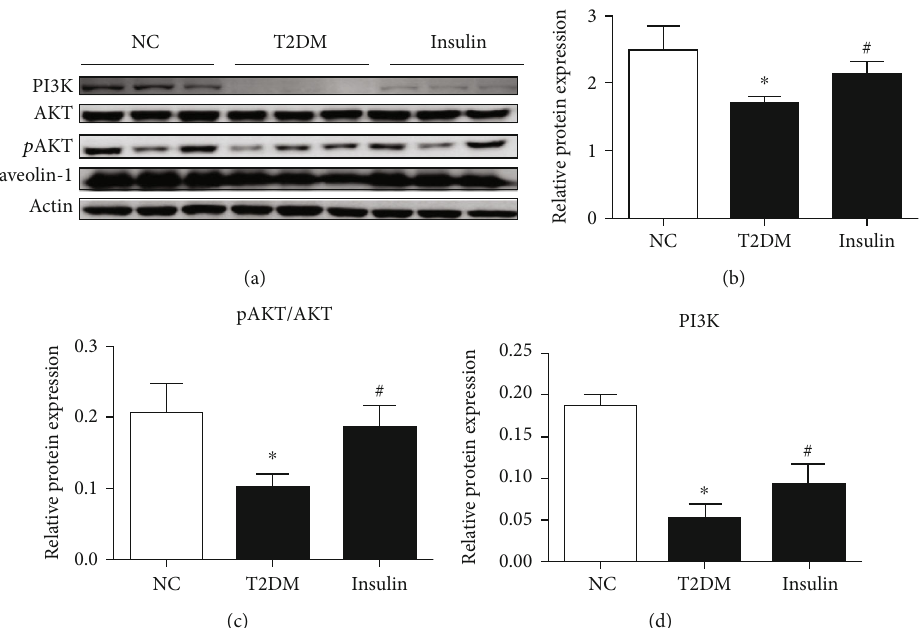
Figure 4: The expression of Caveolin-1, p-AKT/AKT, and PI3K in adipose tissue of NC, type 2 diabetic mice, and insulin-treated T2DM mice (a). The band intensity of Caveolin-1, p-AKT/AKT, and PI3K was quanti fi ed as shown in (b – d), respectively (data presented as mean ± SEM . ∗ P < 0 : 05 vs. NC mice. # P < 0 : 05 compared with T2DM mice, n = 5